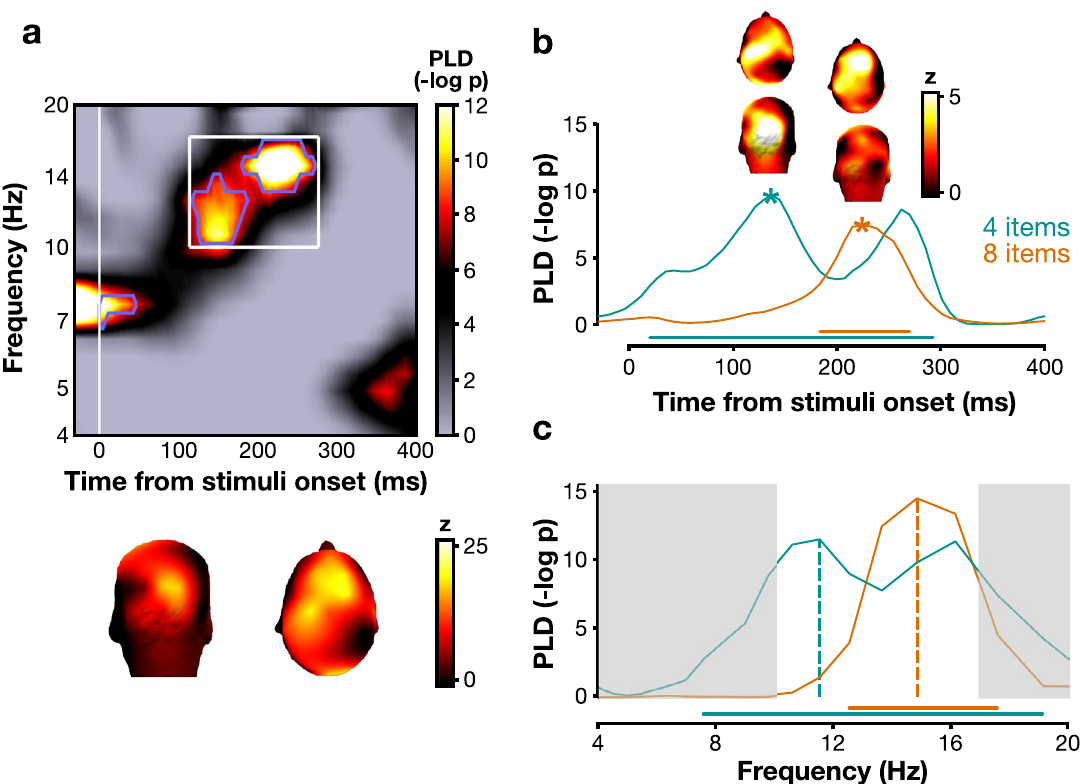
Figure 4. Post-stimulus phase-locking difference between correct and incorrect trials in Experiment 2. ( a ) P value of post-stimulus phase-locking difference (PLD) between correct and incorrect trials for both conditions combined (4 and 8 items), pooled across all electrodes and all participants. Blue contours indicate areas above the FDR threshold (alpha = 10 –7 , corresponding to a p value of 4.4e−9). The bottom topomaps represent the average activity across participants for the time–frequency area within the bounds of FDR-corrected significant blue contours (white rectangle: 114 to 277 ms and 10 to 17 Hz). ( b ) PLD curves plotted after averaging across the frequency range of the significant clusters found in ( a ). Stars mark the timepoint of maximum significance on each trace (4 items: 137 ms; 8 items: 238 ms). Topomaps represent the PLD at each electrode averaged across participants at the timepoint of maximum significance. ( c ) PLD curves plotted against frequency at the timepoint of maximum significance for the 4-item (teal) and 8-item (orange) condition. On both panels, the horizontal bars along the bottom indicate that the curves surpass the FDR threshold (correction for multiple comparisons). The white area indicates the frequency range of interest, taken from the significant PLD clusters in ( a